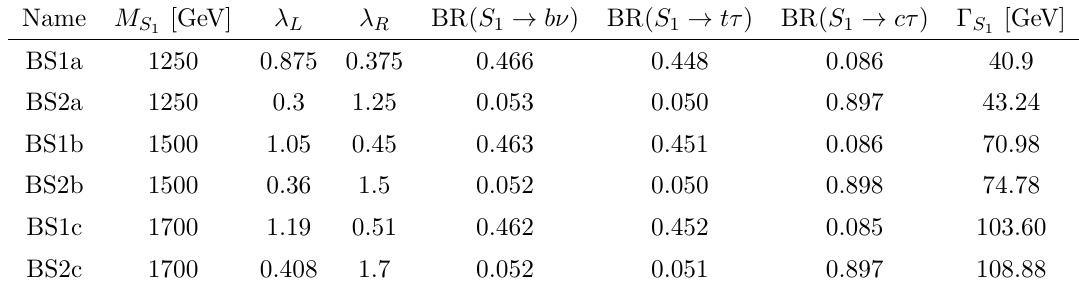
Table 1 . Benchmark scenarios providing an explanation for the flavour anomalies. We have assumed negligible LQ decays into the dark sector ( y